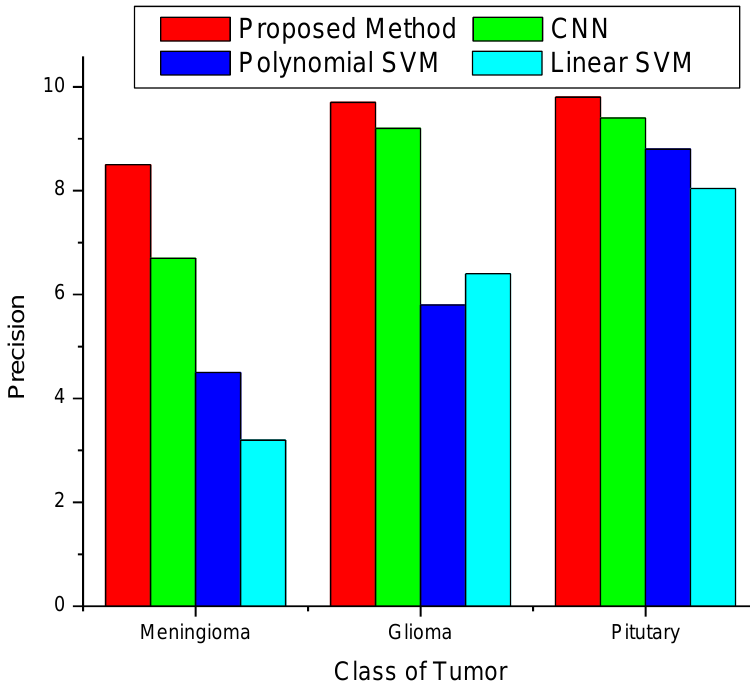
Figure 8. Accuracy of classification method.